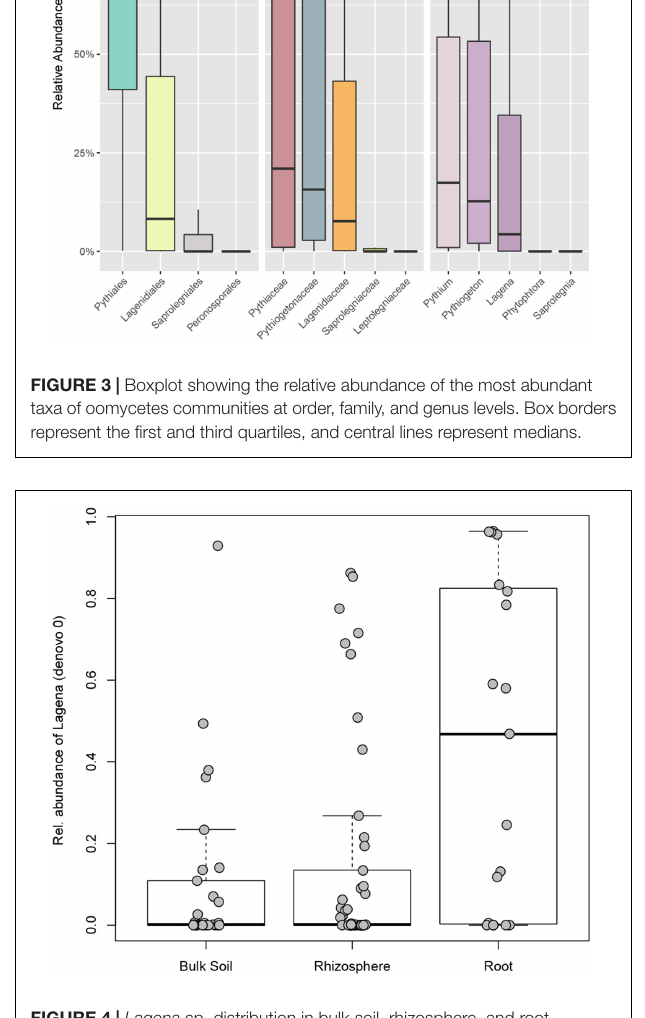
FIGURE 4 | Lagena sp. distribution in bulk soil, rhizosphere, and root samples. Boxplot show the 25% and 75% quartiles of the data, the central line represents the median, bars extend to 95% confidence